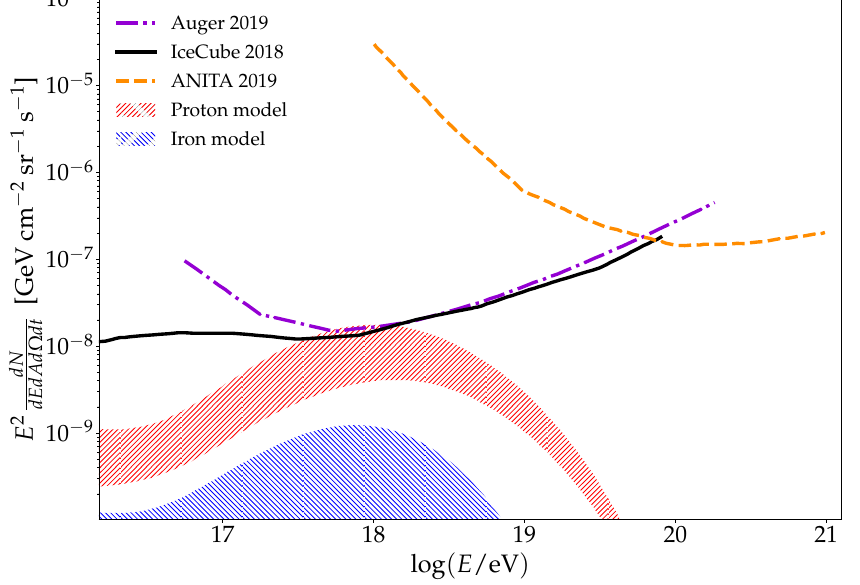
Figure 13. Upper limits on the differential total neutrino flux at 90% confidence level obtained by IceCube [109], Auger [110], and ANITA [111]. The shaded regions correspond to two models (same as the ones in Figure 12) in which the ultra-high-energy cosmic rays are dominated by protons and iron nuclei